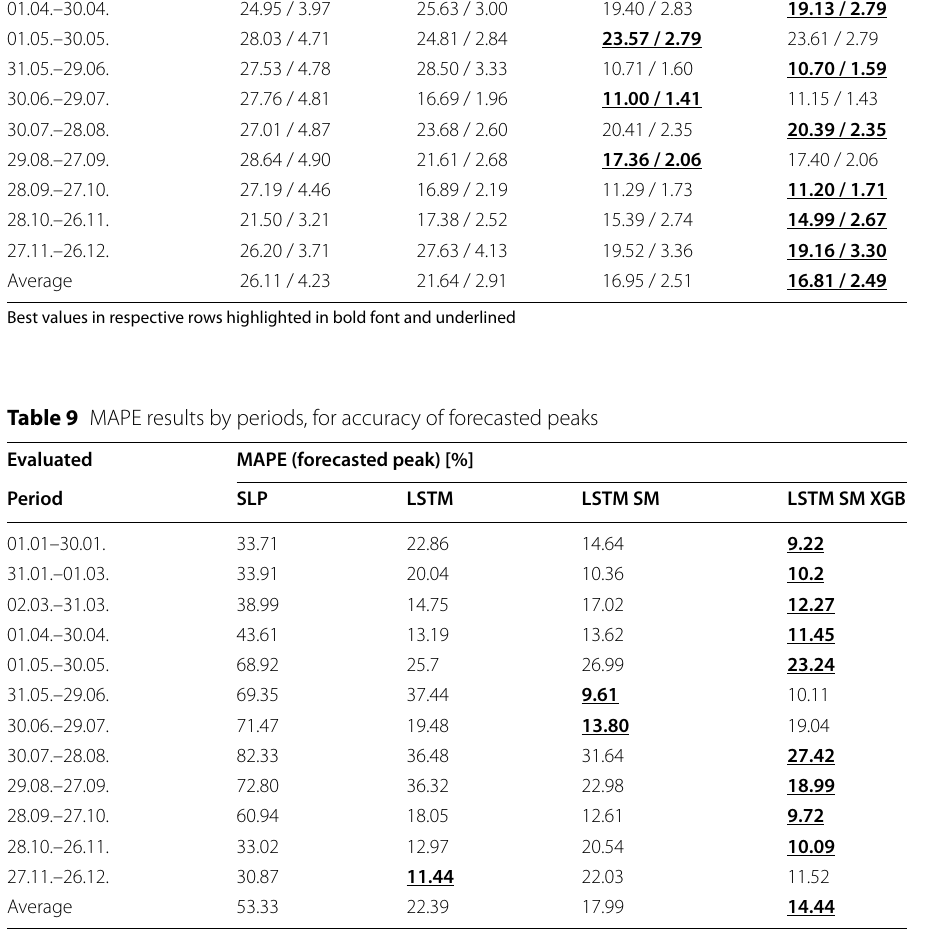
Best values in respective rows highlighted in bold font and underlined